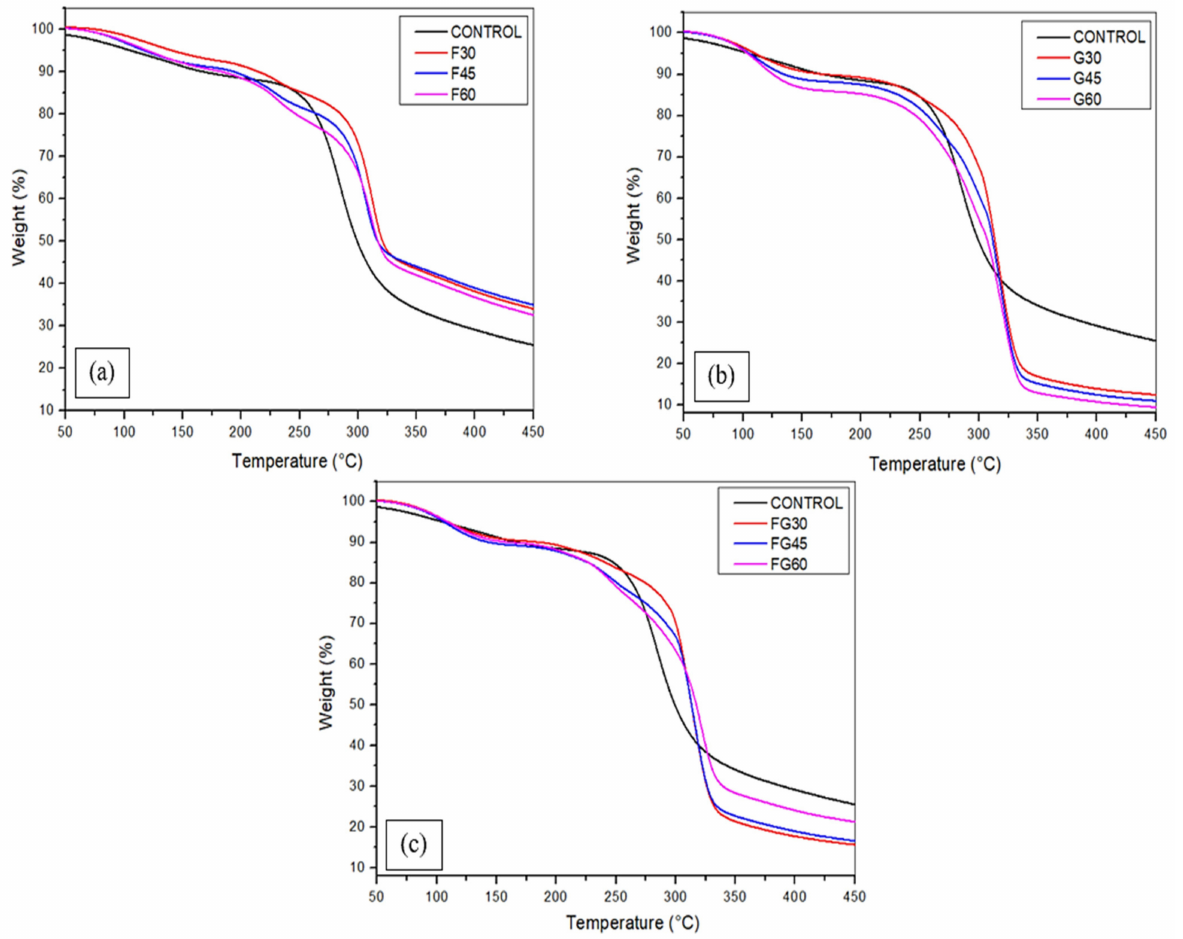
Figure 6. Thermogravimetric analysis of corn starch films with various plasticizers type at different concentrations: